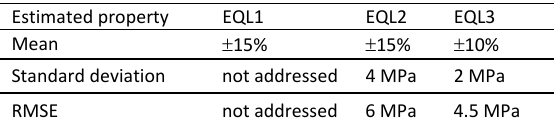
Table 1. relation between estimation quality levels (EQL) and the target tolerance intervals on strength assessment (simplified version).